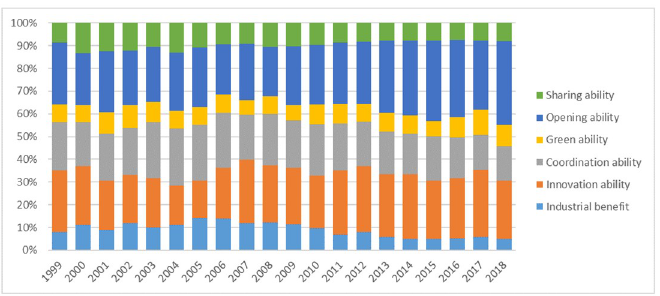
Fig 2. Weights of primary indices in China’s industrial high quality development index system.